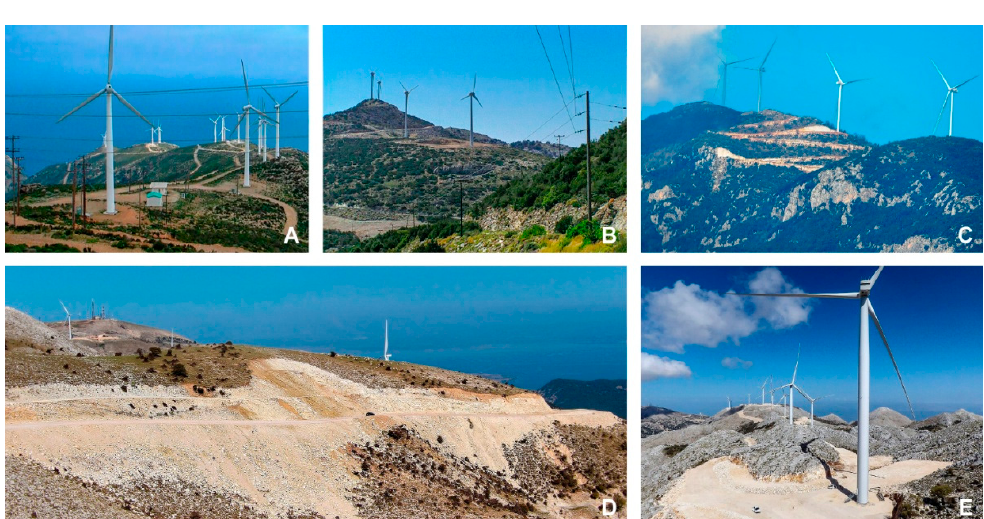
Figure 10. Examples of visual impacts and associated infrastructure of industrial wind farms that may compromise CES attributes. ( A ) Antia, Euboea Island (38.036548, 24.560521), ( B )